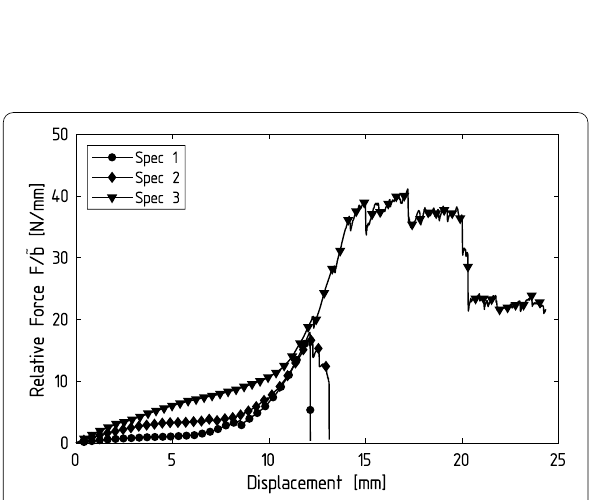
Figure 18 Relative force‑displacement for the climbing drum peel test